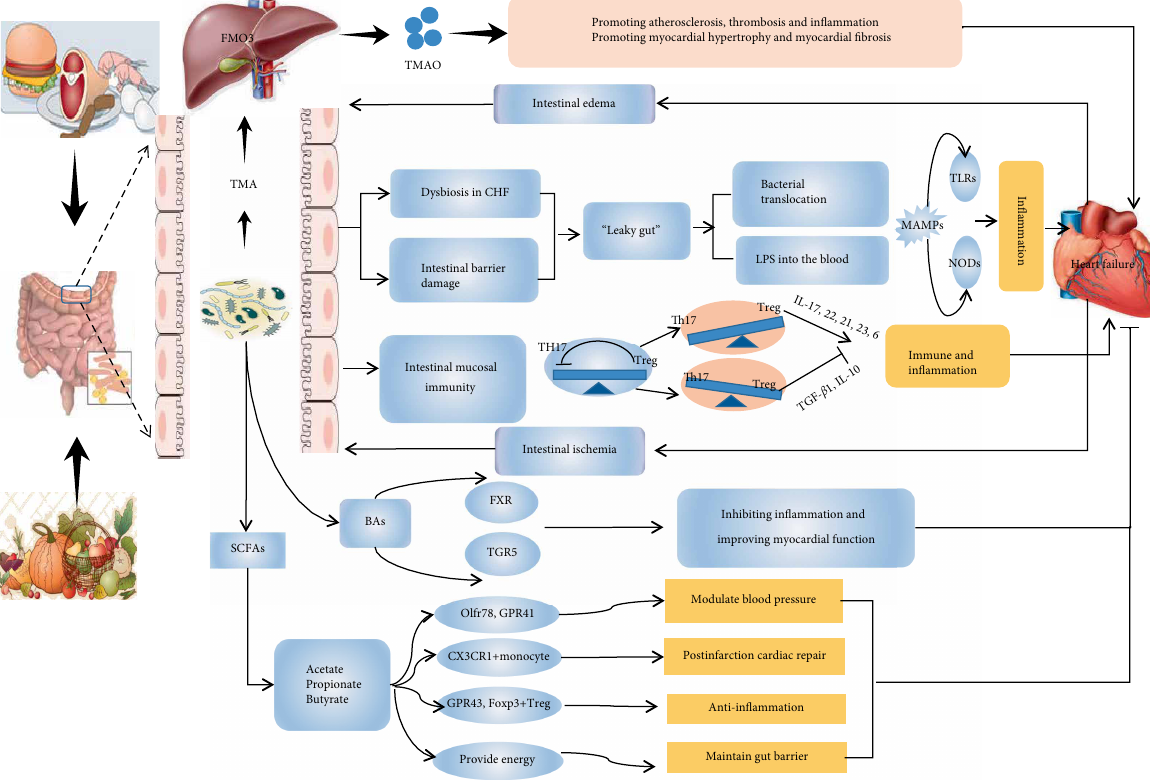
Figure 1: The role of gut microbiota in heart failure. TMA: Trimethylamine; TGF- β : transforming growth factor- β ; TMAO: trimethylamine N-oxide; IL: interleukin; SCFA: short-chain fatty acids; LPS: lipopolysaccharide; FMO3: flavin monooxygenase-3; Treg: regulatory T cells; Th17: helper T cells 17; GPR: G protein receptor; MAMPs: microbe-associated molecular patterns; NOD: nucleotide oligomerization domain; FXR: farnesoid X receptor; TGR5: G-protein coupled bile acid receptor